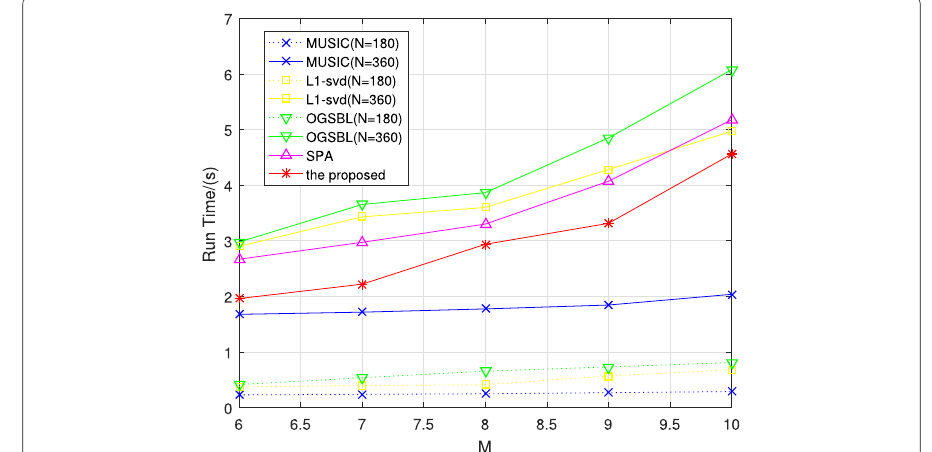
Fig. 6 Run time of five algorithms versus